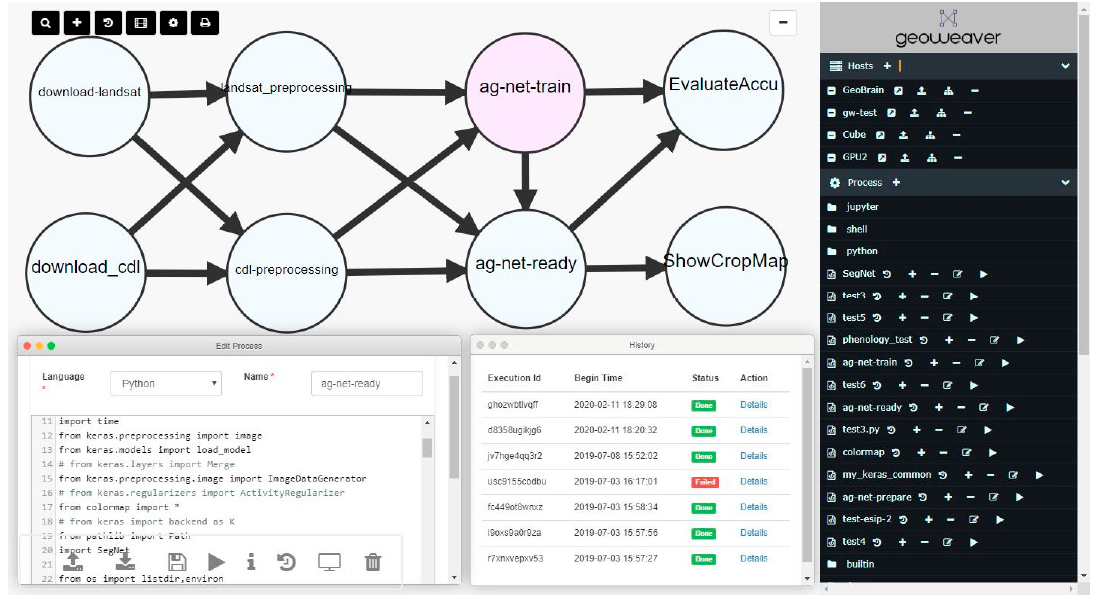
Figure 4. The created GeoWeaver workflow for crop mapping.